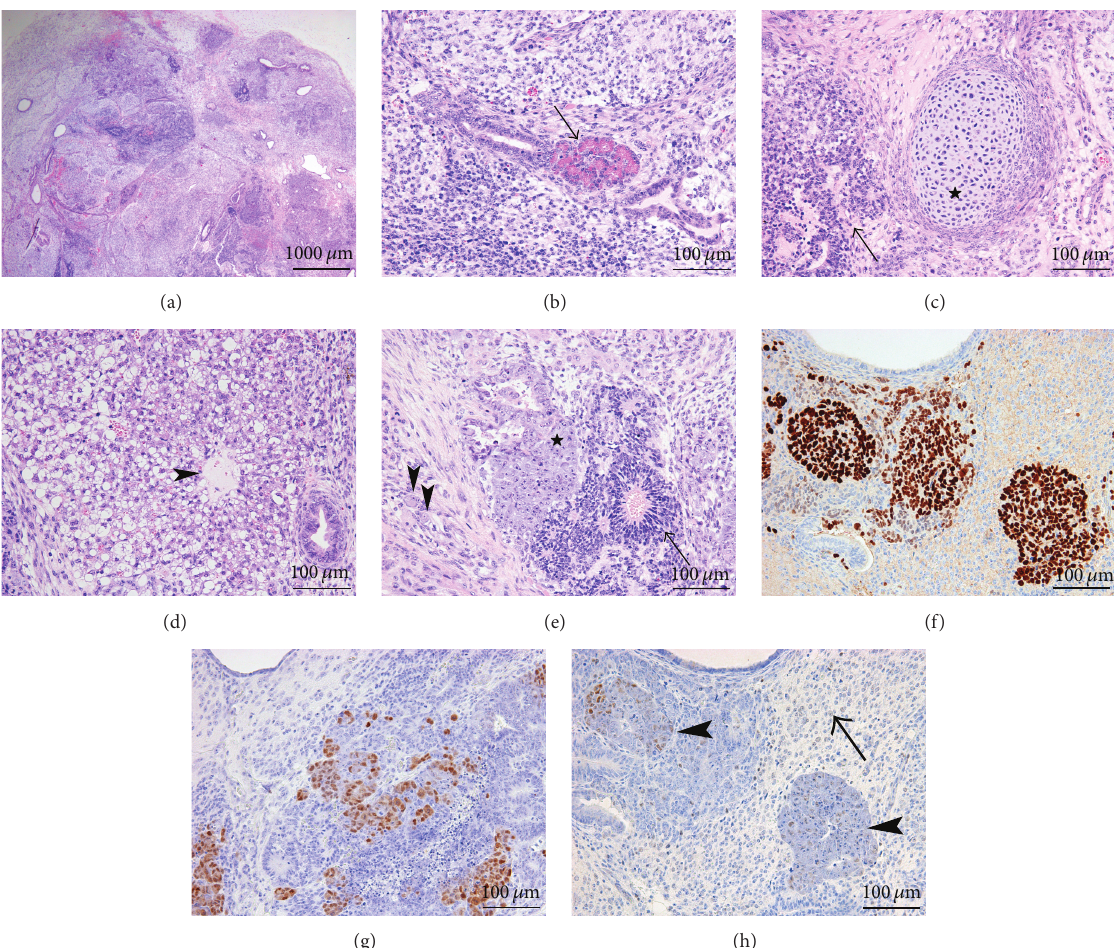
Figure 7: iPSC generated from mouse hepatocytes. All iPSC with mouse hepatic origin produced solid mixed germ cell tumors (a, H&E 20x). The teratoma components showed derivatives from all three germ layers, with development among other endodermal structures of ducts and pancreas ( arrow ) (b, H&E 200x), of cartilage as mesodermal derivative ( star ) (c, H&E 200x) and neuroglial tissue as ectodermal derivative ( arrow ) (c). Fetal-type hepatocyte plates were focally radially arranged around a centrilobular-like vein ( arrowhead ) (d, H&E 200x). A minor embryonal carcinoma component was composed of tumor cells arranged in cords and gland-like structures and forming small dispersed nests ( star ) within the neuroglial component ( arrow ); ganglion-like cells ( arrowheads ) are also seen (e, H&E 200x). Strong nuclear reactivity toSALL4(f,200x)andOCT4(g,200x)wasseenintheembryonalcarcinomacells.MYCnuclearreactivitywasfaintandfocalintheembryonal carcinoma component and moderate only in less than 1% of the cells ( arrowheads ); a minority of the neuroglial cells ( arrow ) also showed very faint nuclear staining (h,